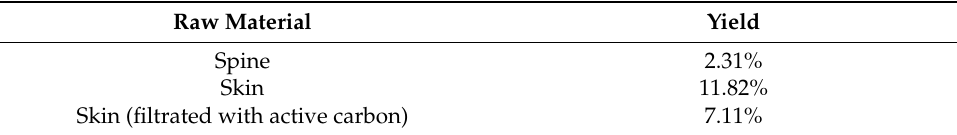
Table 4. Extraction yield of fish